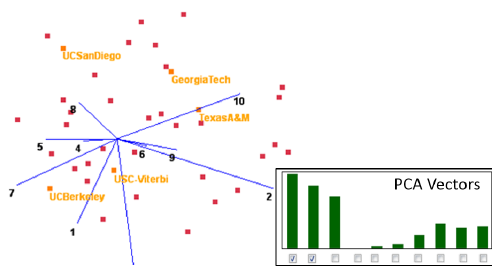
Figure 1. High-dimensional scatterplot, college